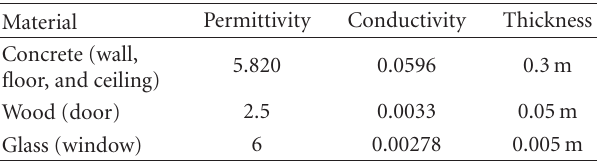
Table 1: Material properties used at 2.1 GHz.